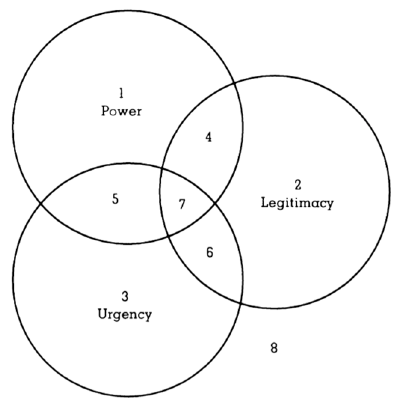
Figure 7. Stakeholder classification framework (Mitchell et al. 1997, p. 874).